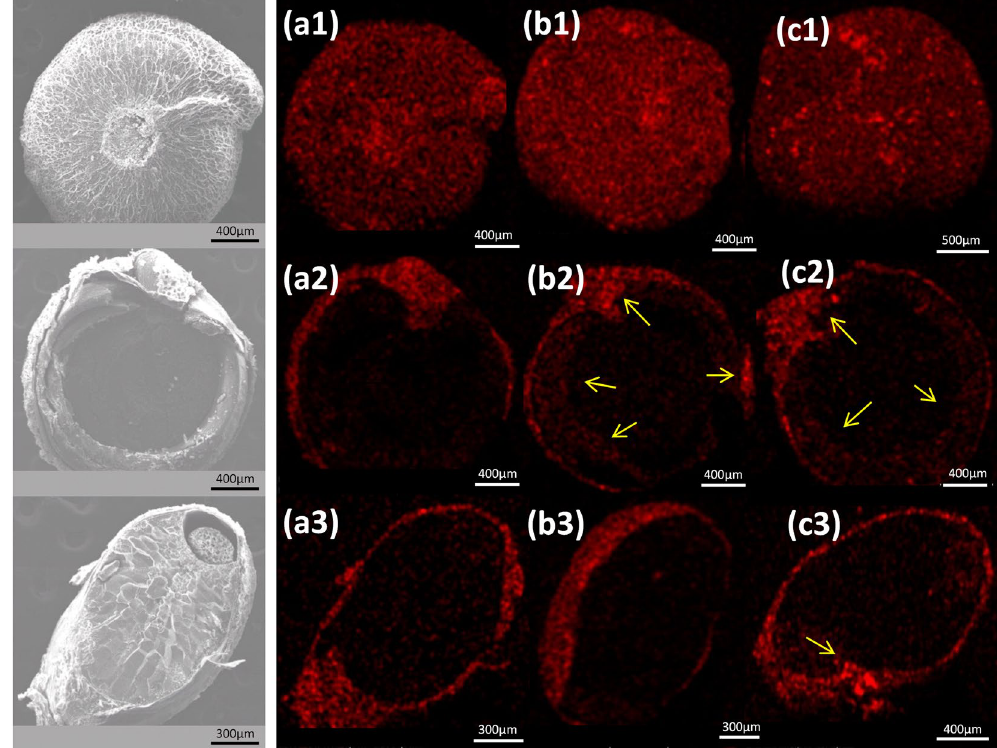
Figure 4. Left) Low magnification SEM micrographs for a Quinoa seed in its original form (top) and for two sections along transversal (center) and longitudinal (bottom) planes. These images clearly show the perisperm, the embryo, the radicle tip, the seed coat and the pericarp (see refs 1 and 42). Right) EDX maps of potassium for equivalent observation zones of original seeds “as received” (a1) and after 15 min (b1) and 50 min (c2) DBD plasma treatment. Similar maps for transversal (a2–c2) and longitudinal (a3–c3) sections of plasma treated seeds. The yellow arrows in the images indicate K migration to these